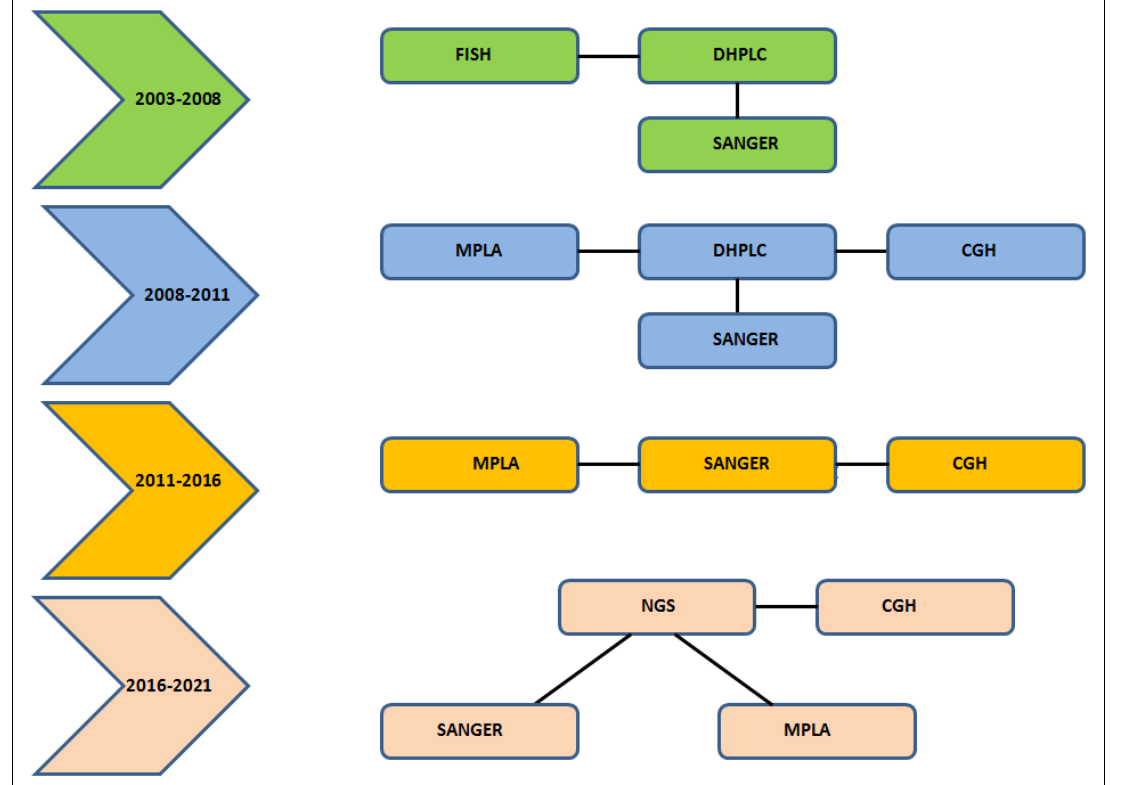
Figure 1. Workflow analysis. We reported the schematic representation of the whole study strategy used from 2003 to 2021. Several colors represent the different strategies of investigation in the 18 years of laboratory analysis.